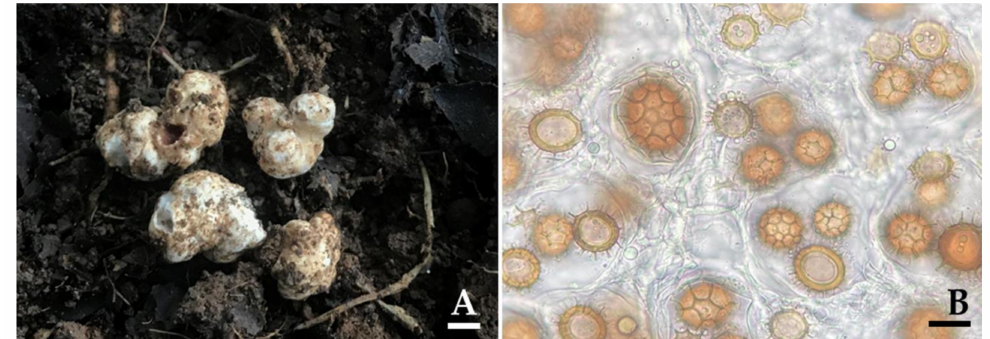
Figure 4. Ascocarps ( A ) and ascospores ( B ) of Tuber thailadicum collected from the representative locations of the truffle OTU (B14). Scale bar: A = 1 cm and B = 25 µ